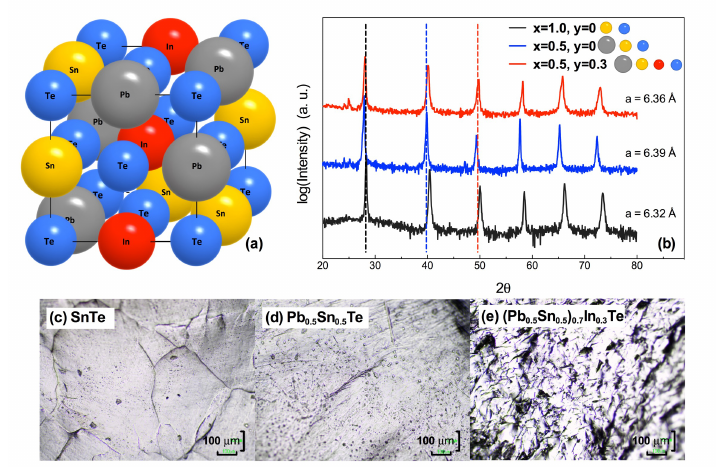
Figure 1. ( a ) A sketch of the crystal structure of SnTe with Sn atoms (yellow) partially replaced by Pb (grey) and In (red); ( b ) X-ray powder diffraction (XRD) patterns for SnTe (black), Pb 0.5 Sn 0.5 Te (blue), and (Pb 0.5 Sn 0.5 ) 0.7 In 0.3 Te (red), respectively. Each dashed line marks the position of an XRD peak of a compound with the same color; ( c – e ) Optical microscope photos of the pristine surface of ( c ) SnTe, ( d ) Pb 0.5 Sn 0.5 Te, and ( e ) (Pb 0.5 Sn 0.5 ) 0.7 In 0.3 Te